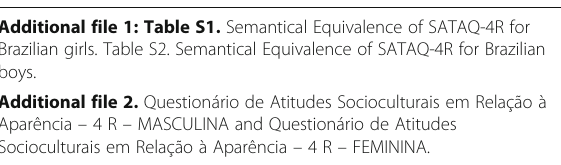
Additional file 1: Table S1. Semantical Equivalence of SATAQ-4R for Brazilian girls. Table S2. Semantical Equivalence of SATAQ-4R for Brazilian